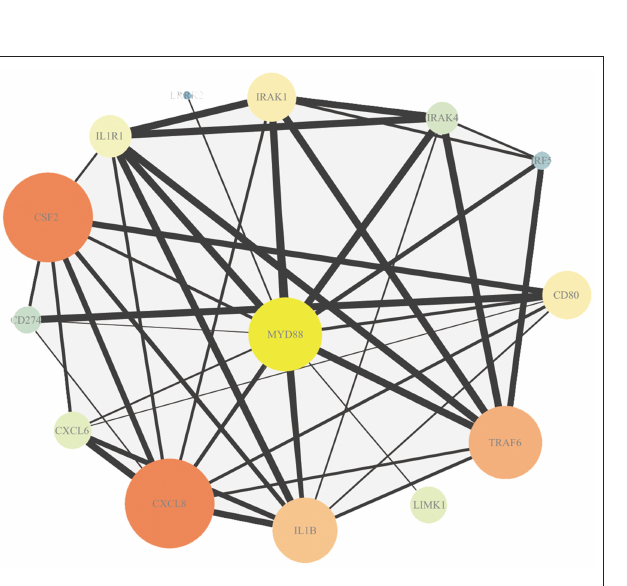
FIGURE 3 | Protein–protein interaction (PPI) analysis of DEmRNAs. Map node size and color to degree, low values to small sizes and dark colors. Map edge size to the combined source, low values to small